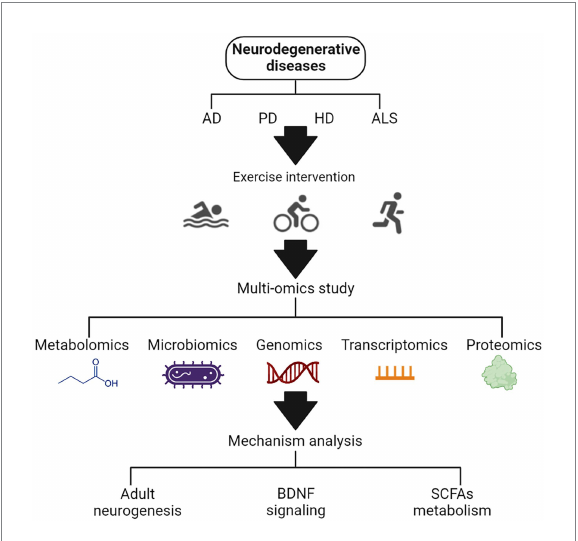
FIGURE 1 The schematic diagram of the effects of exercise on neurodegenerative diseases based on multi-omics